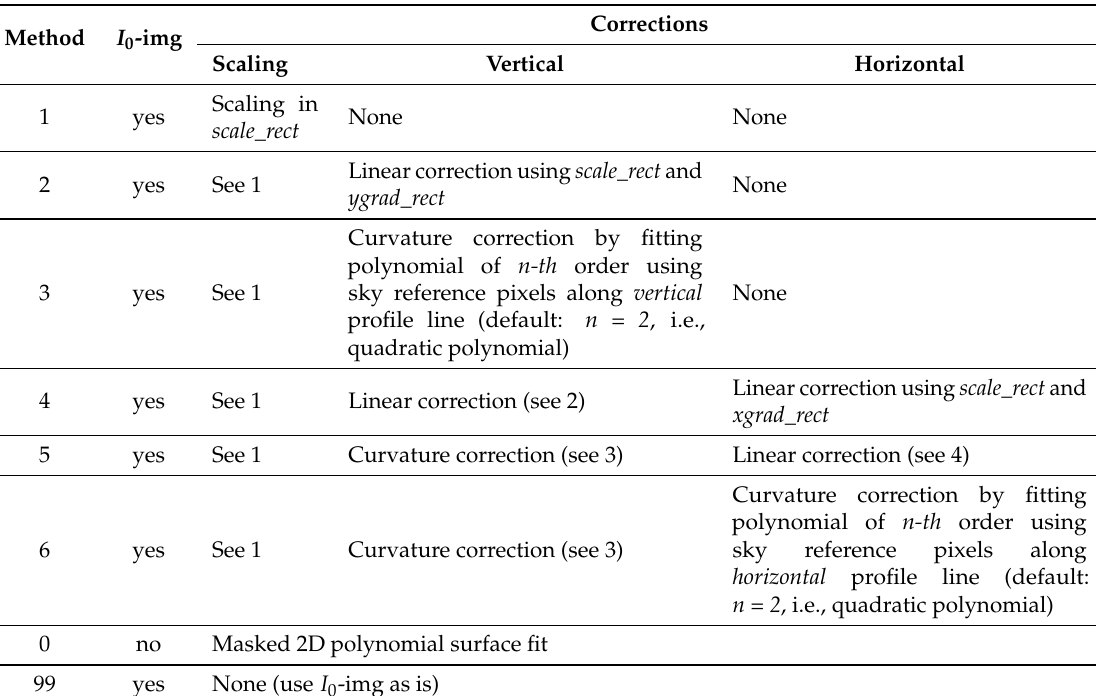
Table 2. Available plume background modelling methods of the PlumeBackgroundModel class (cf. names of sky reference areas in Figure